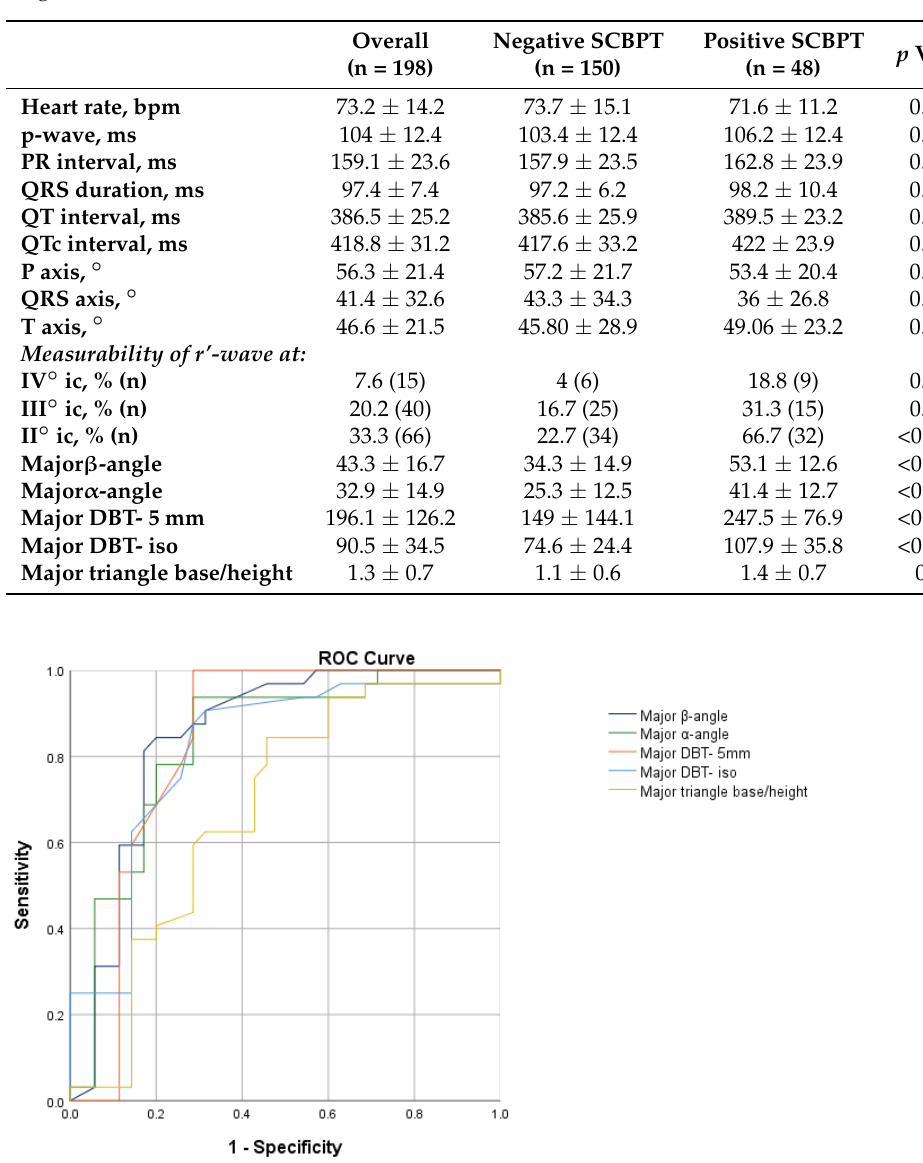
Table 3. Comparison of ECG characteristics and criteria of the test cohort based on Brugada syndrome diagnosis after Sodium Channel Blocker Provocation Test.